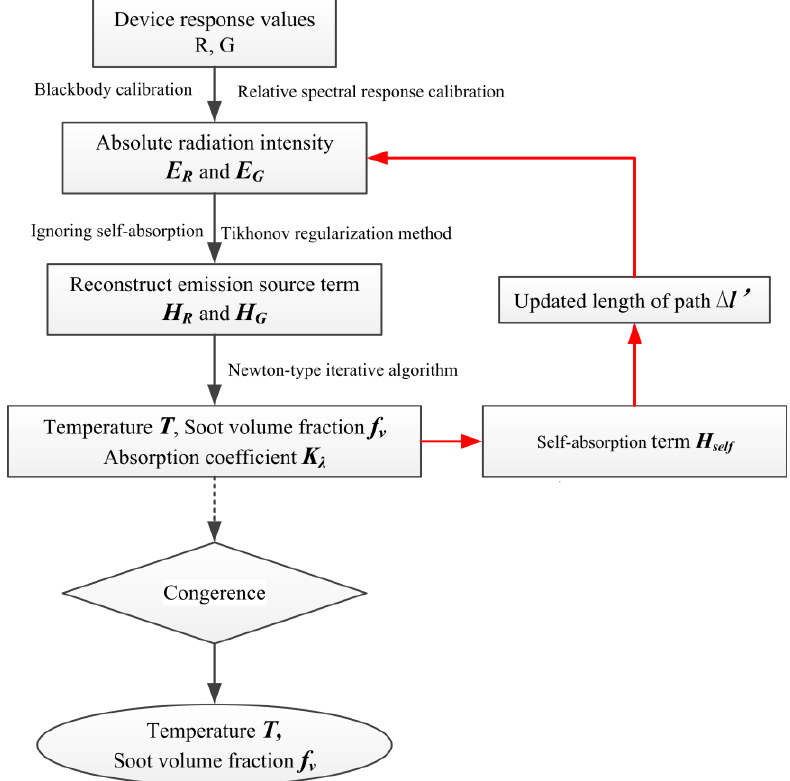
Figure 1. Flow diagram of iterative reconstruction.